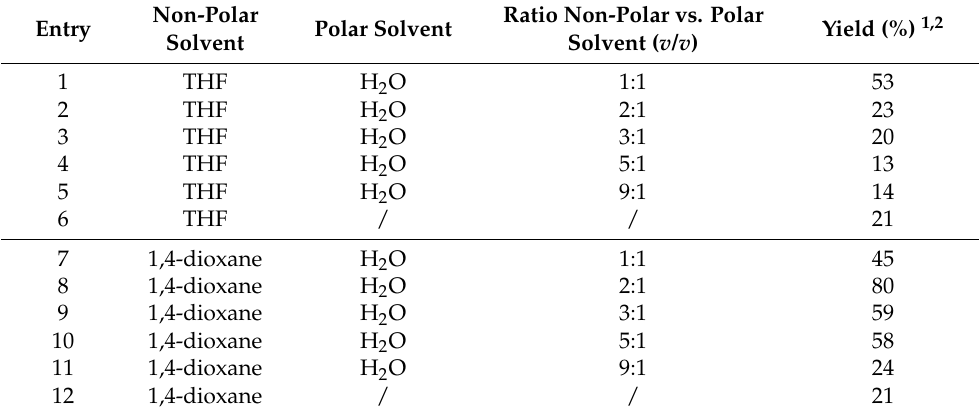
Table 3. Solvent mixture screening for Suzuki coupling of 1 with 2 .